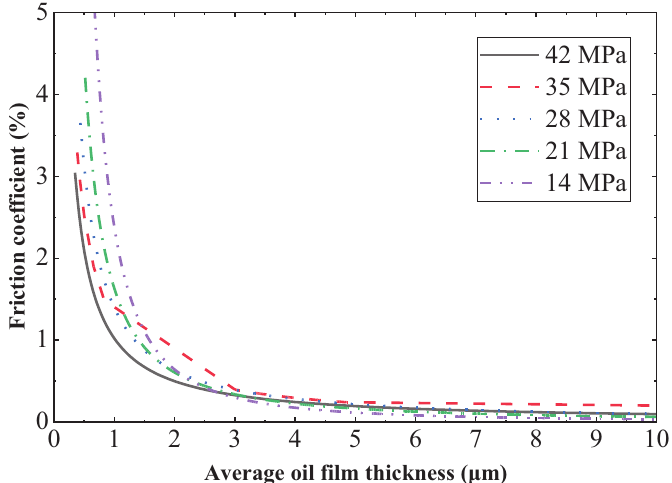
Figure 17. The relationship between the oil film thickness and friction